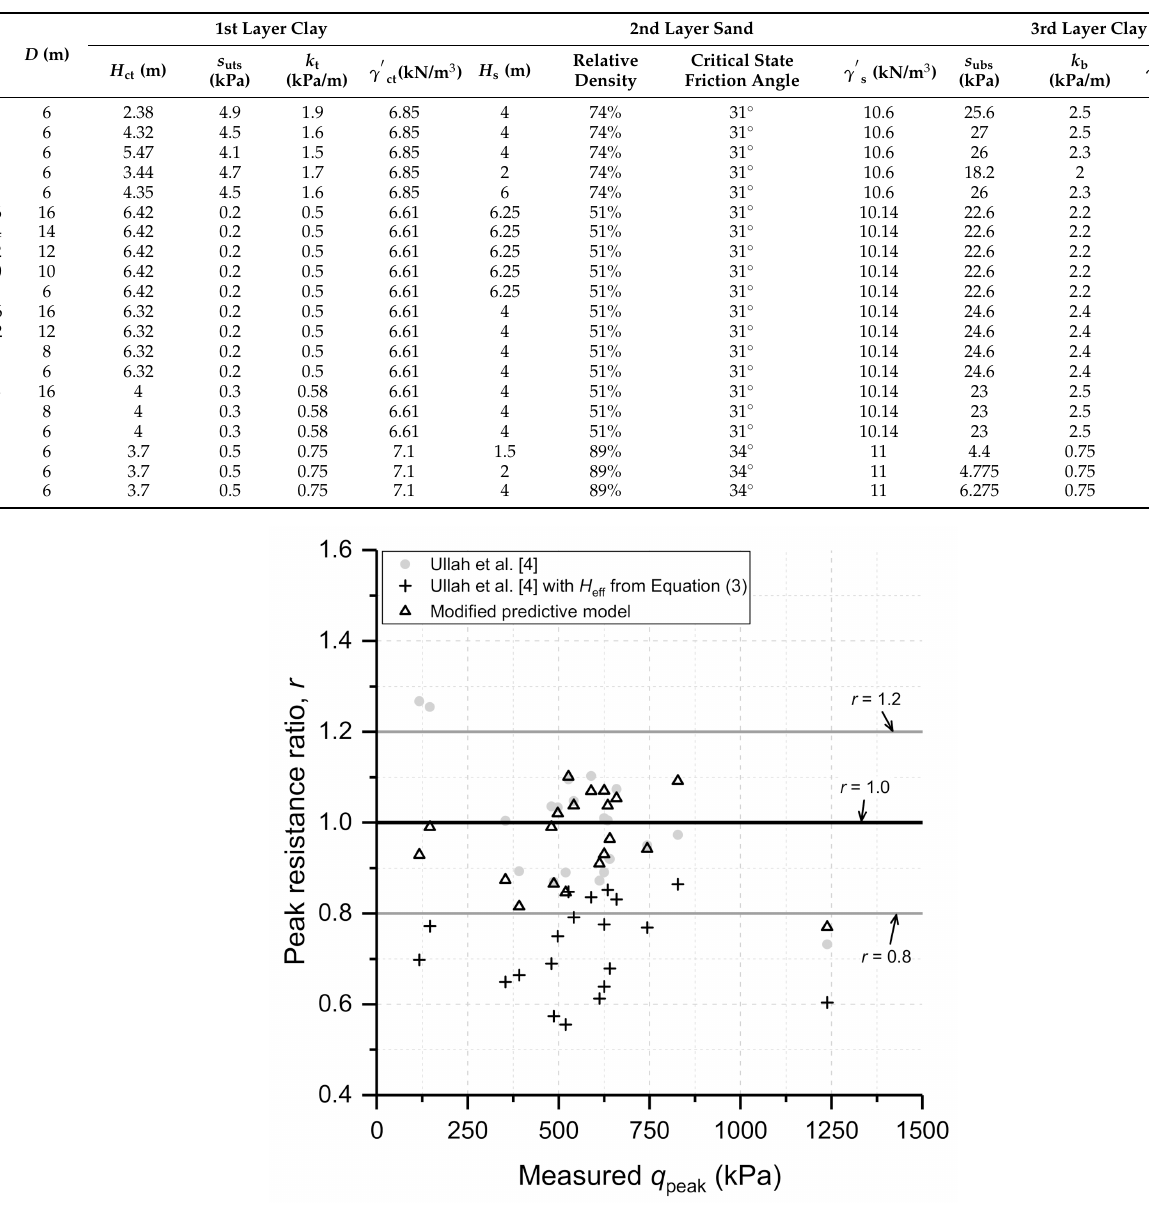
Figure 2. Comparison between measured and predicted peak